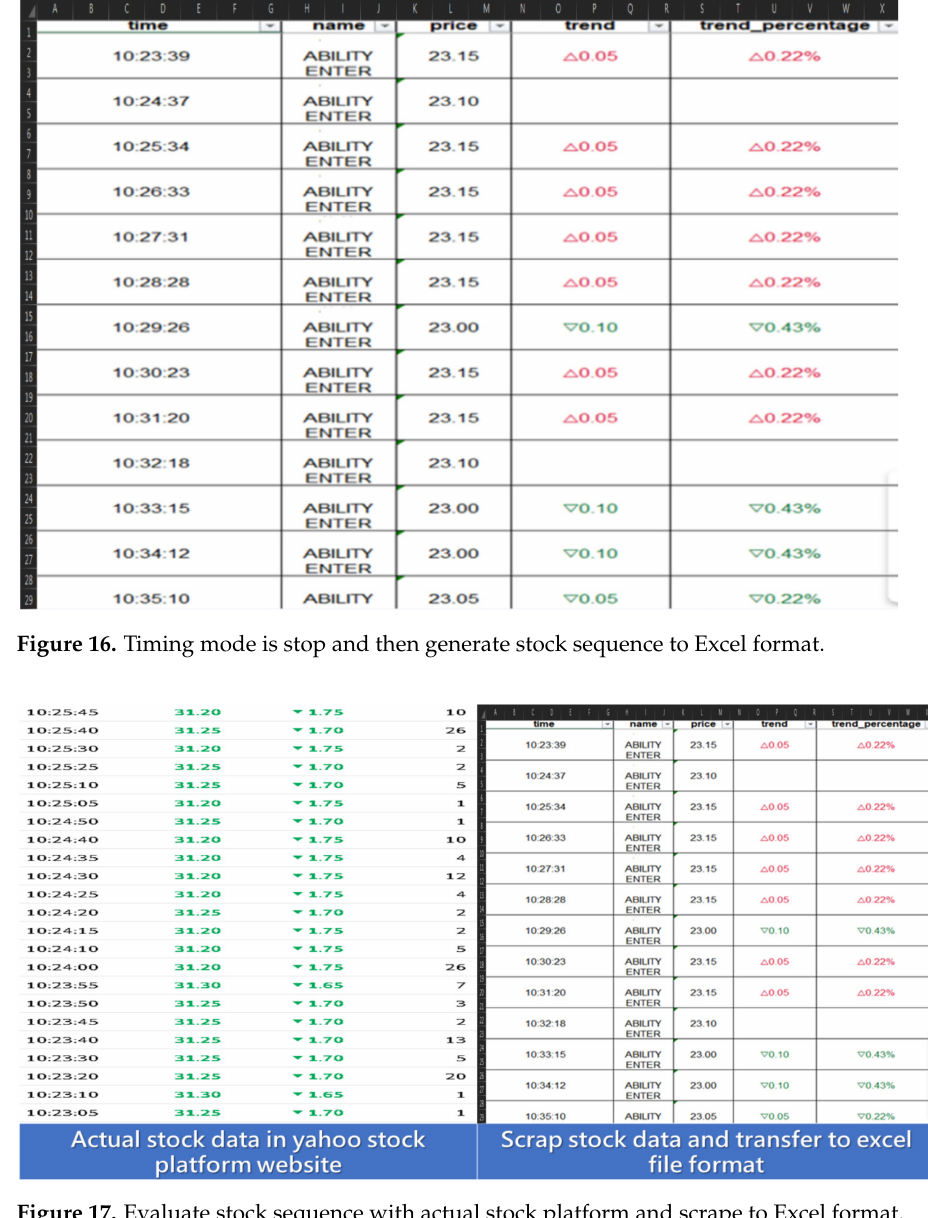
Figure 17. Evaluate stock sequence with actual stock platform and scrape to Excel format.